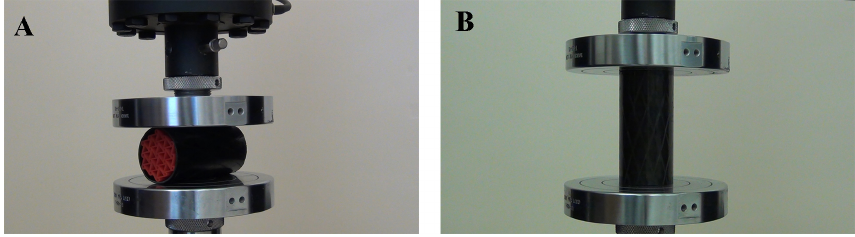
Figure 6. Lateral ( A ) and uniaxial ( B ) crushing of the auxetic structure filled composite tube.